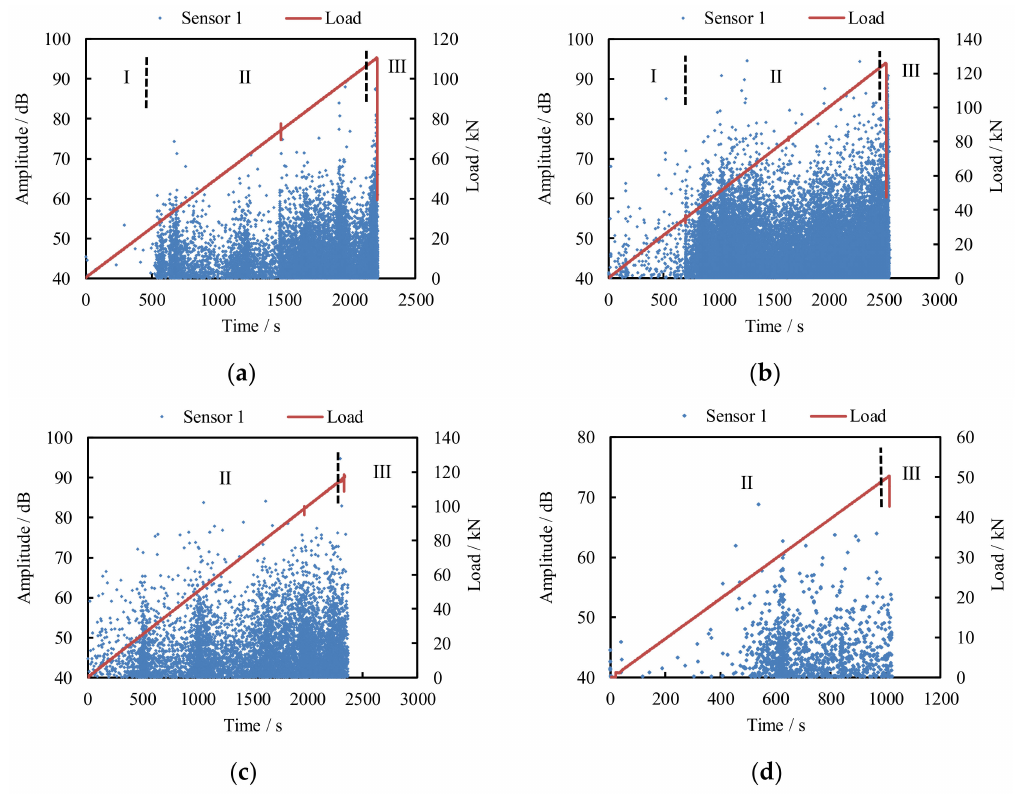
Figure 12. AE parameters amplitude: ( a ) RPC beam; ( b ) BFRPC beam; ( c ) BFRPC-N beam; ( d ) BFRPC-N-ID